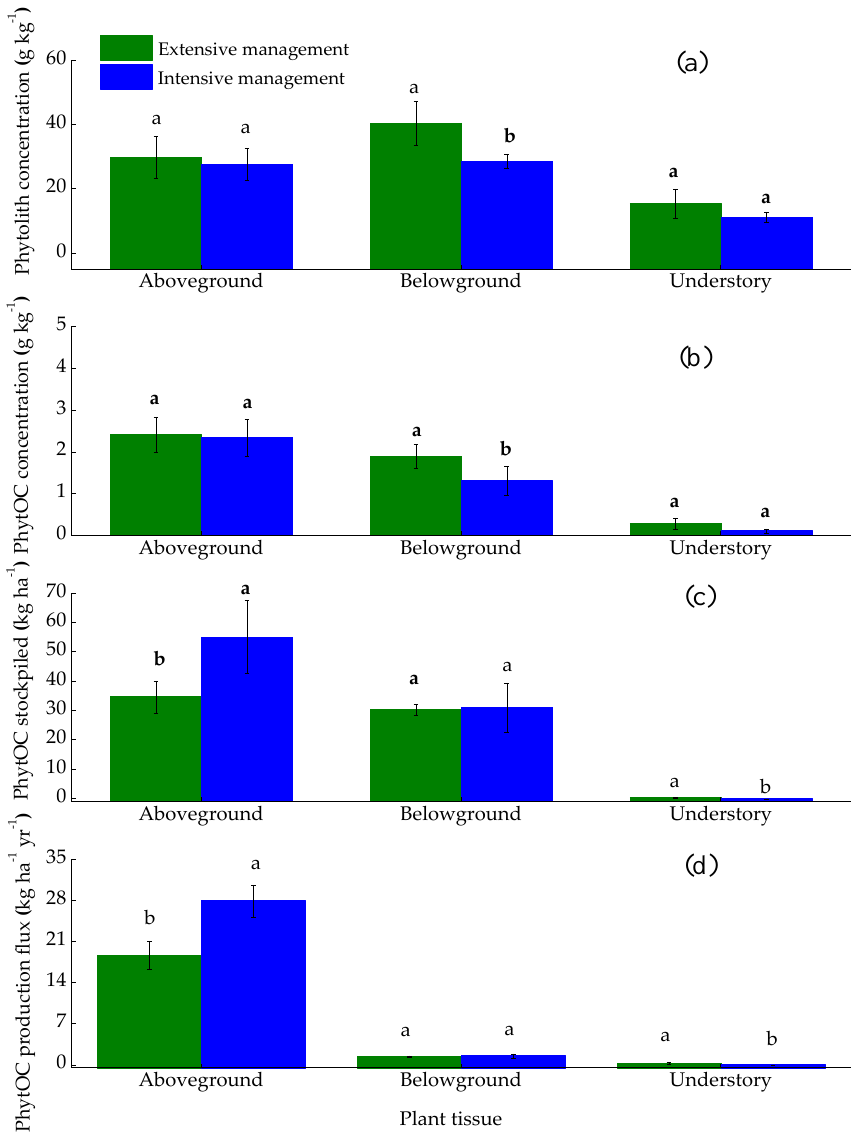
Figure 2. ( a ) phytolith concentration, ( b ) PhytOC concentration, ( c ) PhytOC storage and ( d ) PhytOC production flux in di ff erent part of P. pubescens stands and understory with di ff erent management production flux in different part of P. pubescens stands and understory with different management intensities. Di ff erent letters within a column indicate significant di ff erences between the di ff erent intensities. Different letters within a column indicate significant differences between the different management intensities within the same plant tissue at the p = 0.05 management intensities within the same plant tissue at the p = 0.05 level.